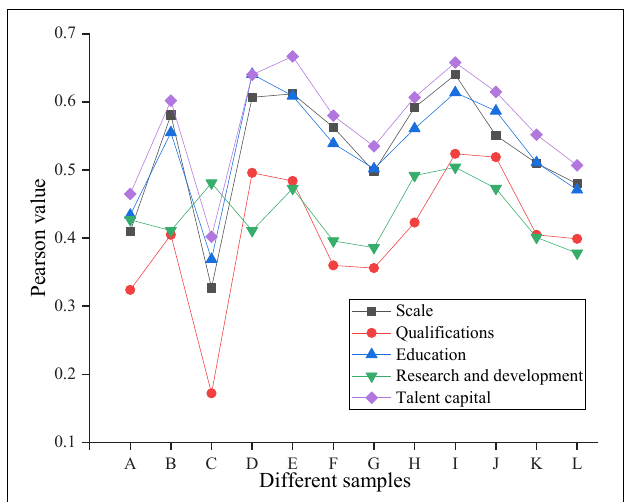
FIGURE 8 | Correlation analysis of Pearson coefficient (R&D